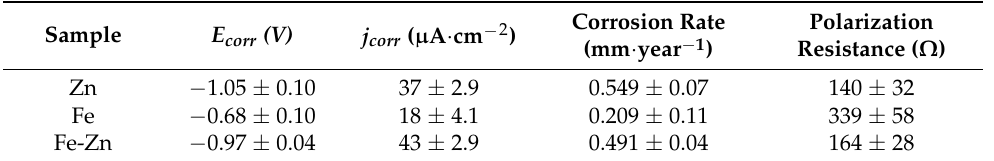
Table 1. Electrochemical parameters of Zn, Fe and Fe-Zn compressed metallic powders measured in Hanks ´ solution at 37 ± 2 ◦ C.